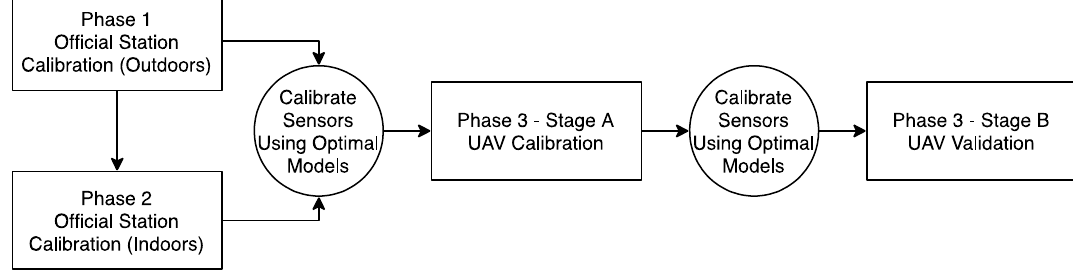
Figure 3. Experimental setup for calibrating electrochemical sensors with UAV integration in.